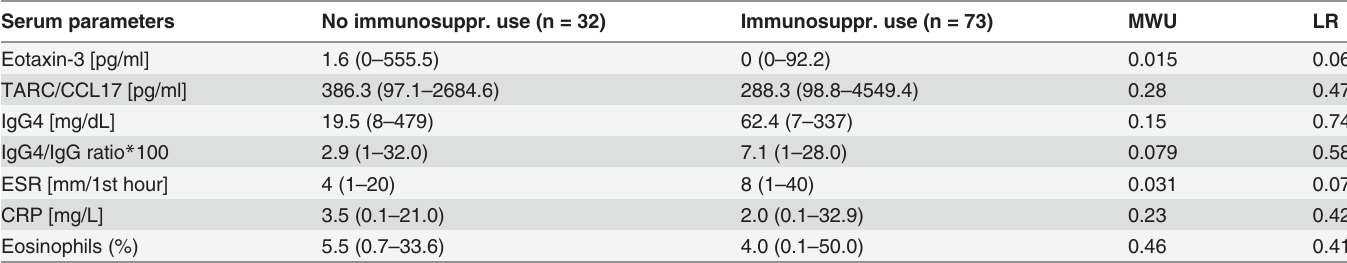
Table 4. Serum biomarkers of patients with EGPA based on use of immunosuppressive agents at time of study visit. Serum